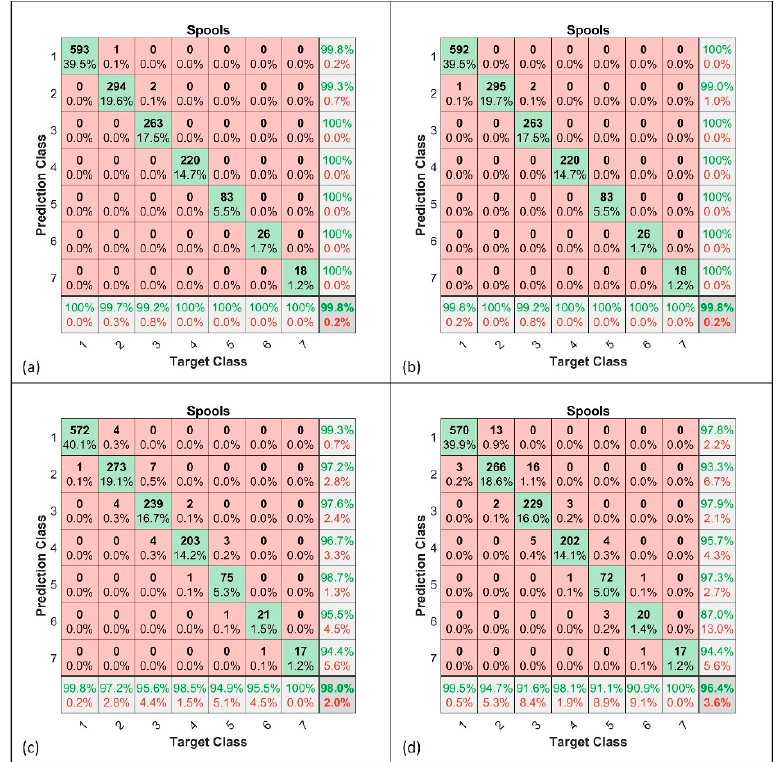
Figure 15. Confusion matrix for shaft transmissions. ( a ): Single-component FFNN; ( b ): single- component KPCA + FFNN; ( c ): multi-component FFNN; ( d ): multi-component KPCA + FFNN.